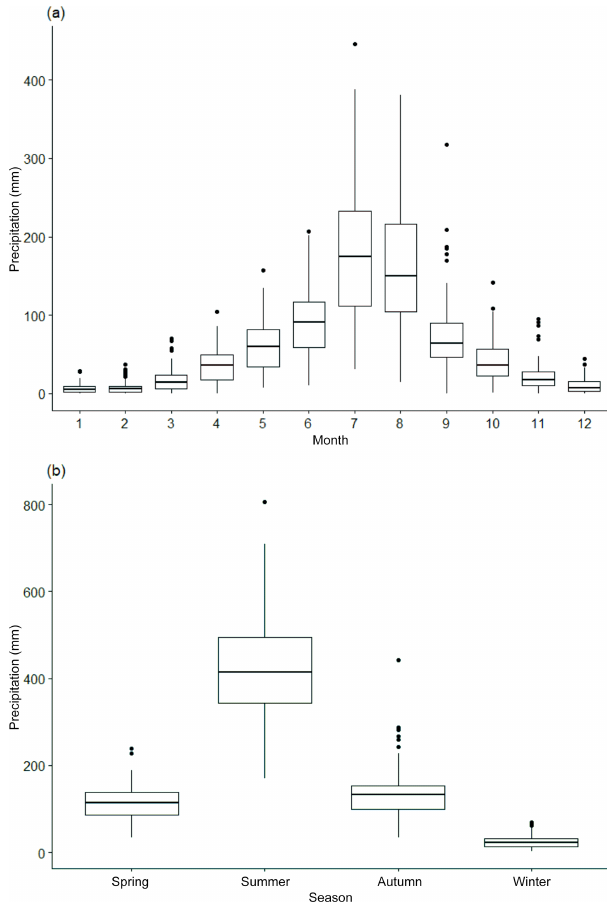
Figure 3. (a) Monthly and (b) seasonal precipitation box charts for